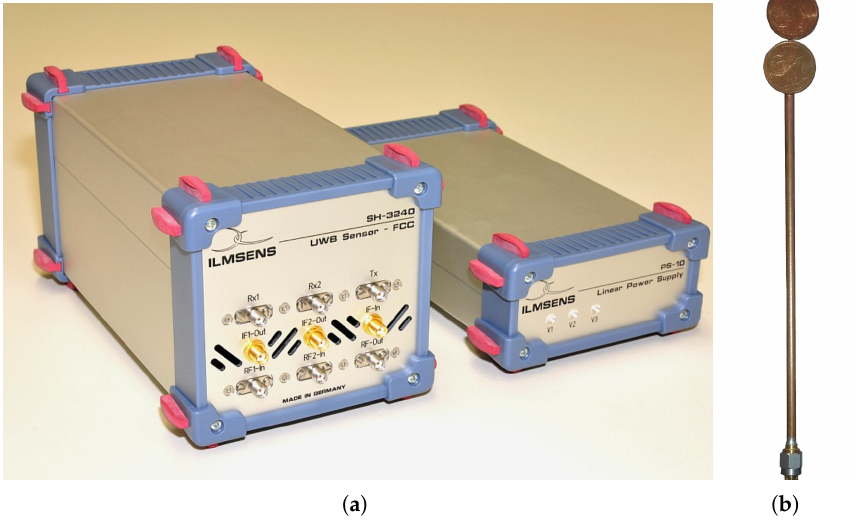
Figure 2. Photos of the measurement hardware showing ( a ) the Ilmsens ultra-wideband (UWB) M-Sequence channel sounder and ( b ) a coin UWB dipole